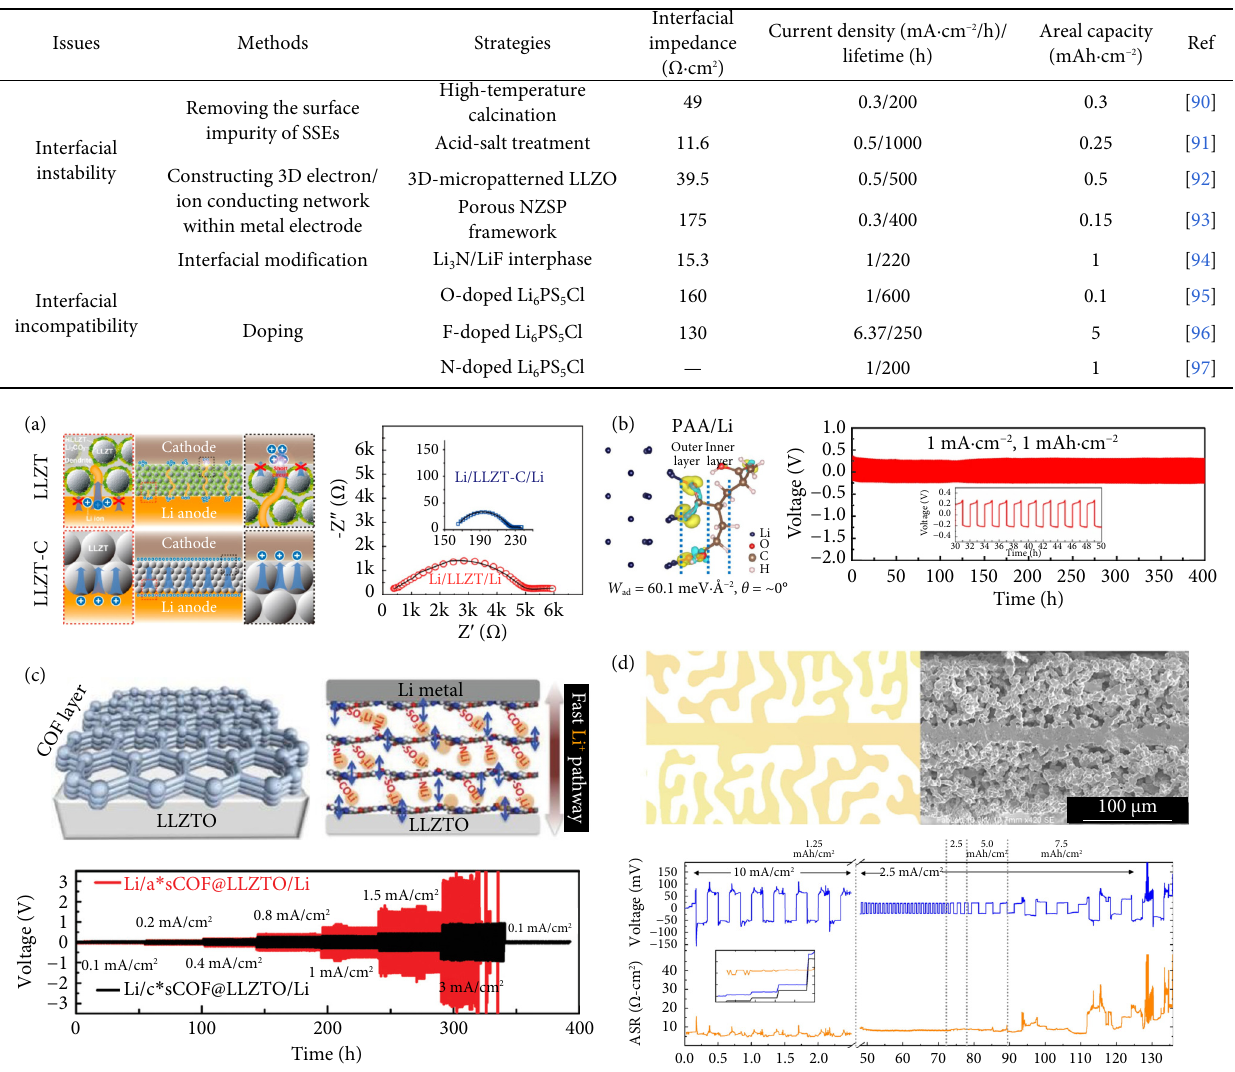
Table 3 Efforts on solid–solid interphase construction Issues